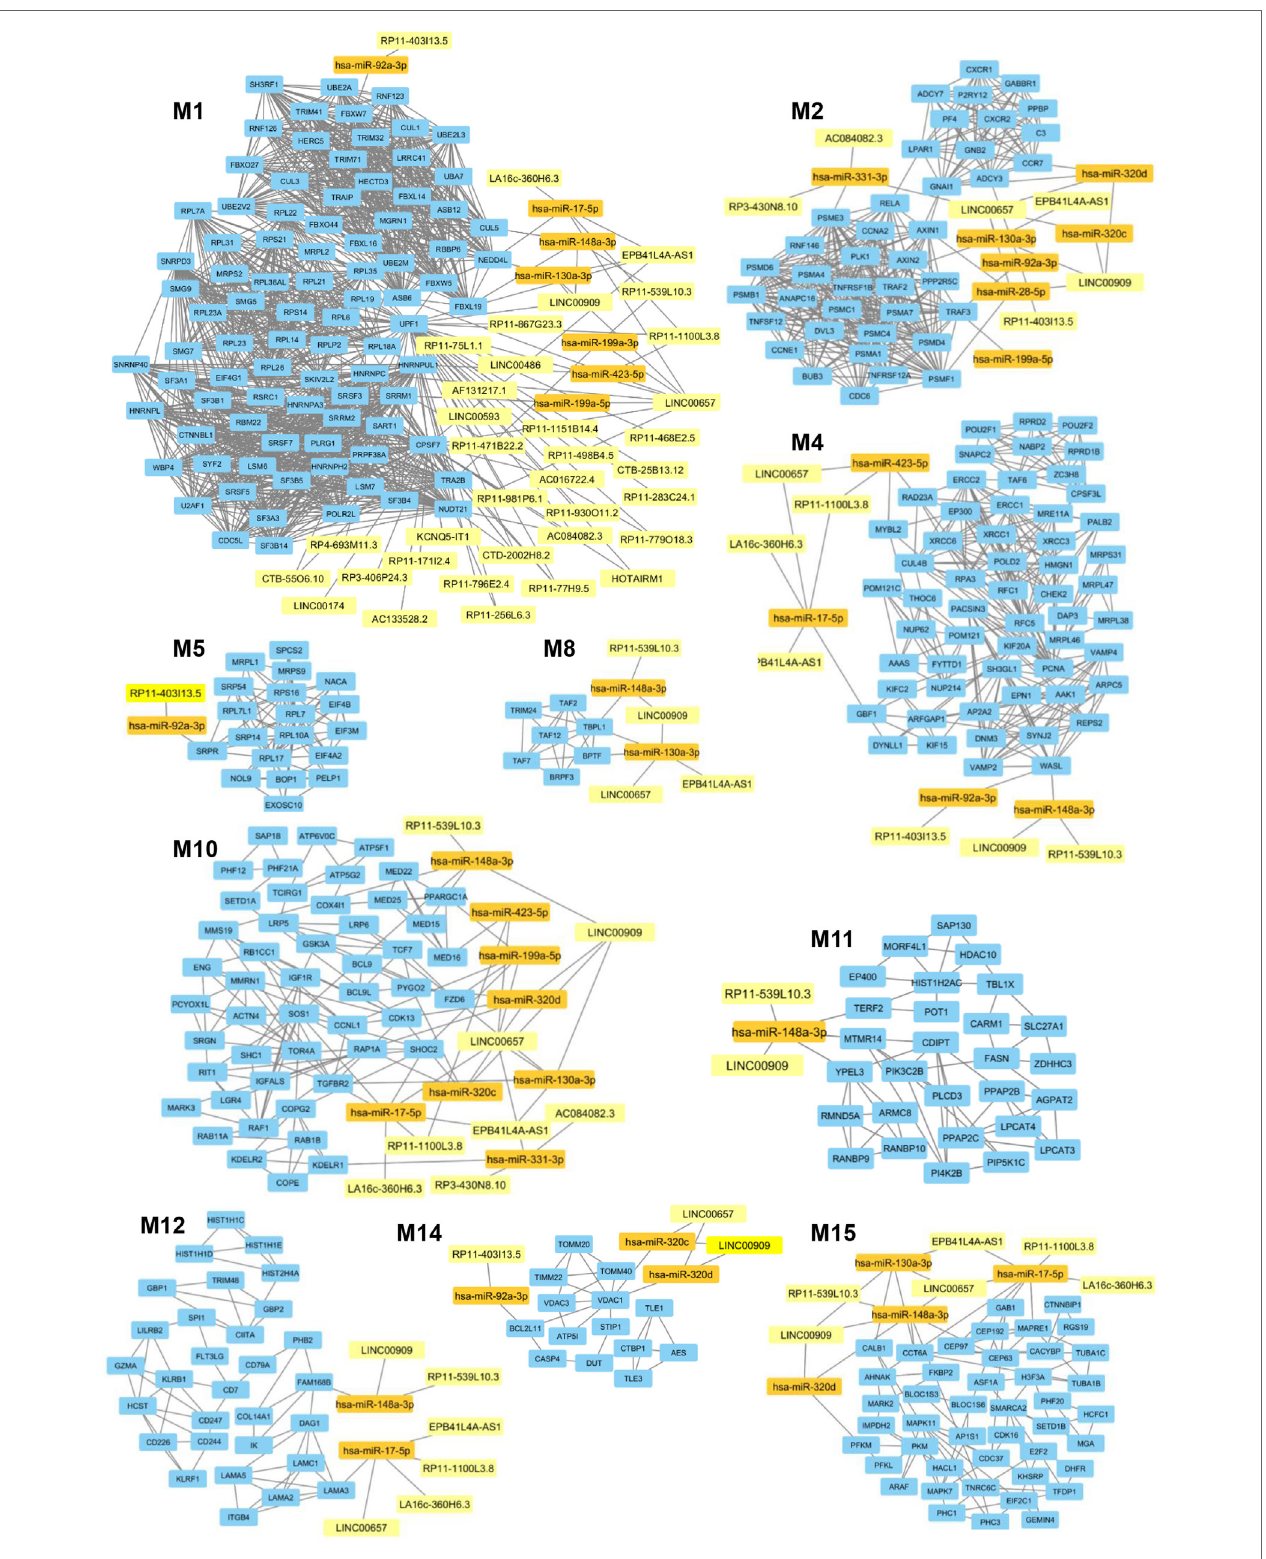
FigUre 4 | Gene modules that are targeted by the selected long non-coding RNAs (lncRNAs) modulated in psoriatic arthritis. In each module (M) genes are represented by light blue rectangles whereas targeting microRNAs and lncRNAs are represented by orange and yellow rectangles, respectively.